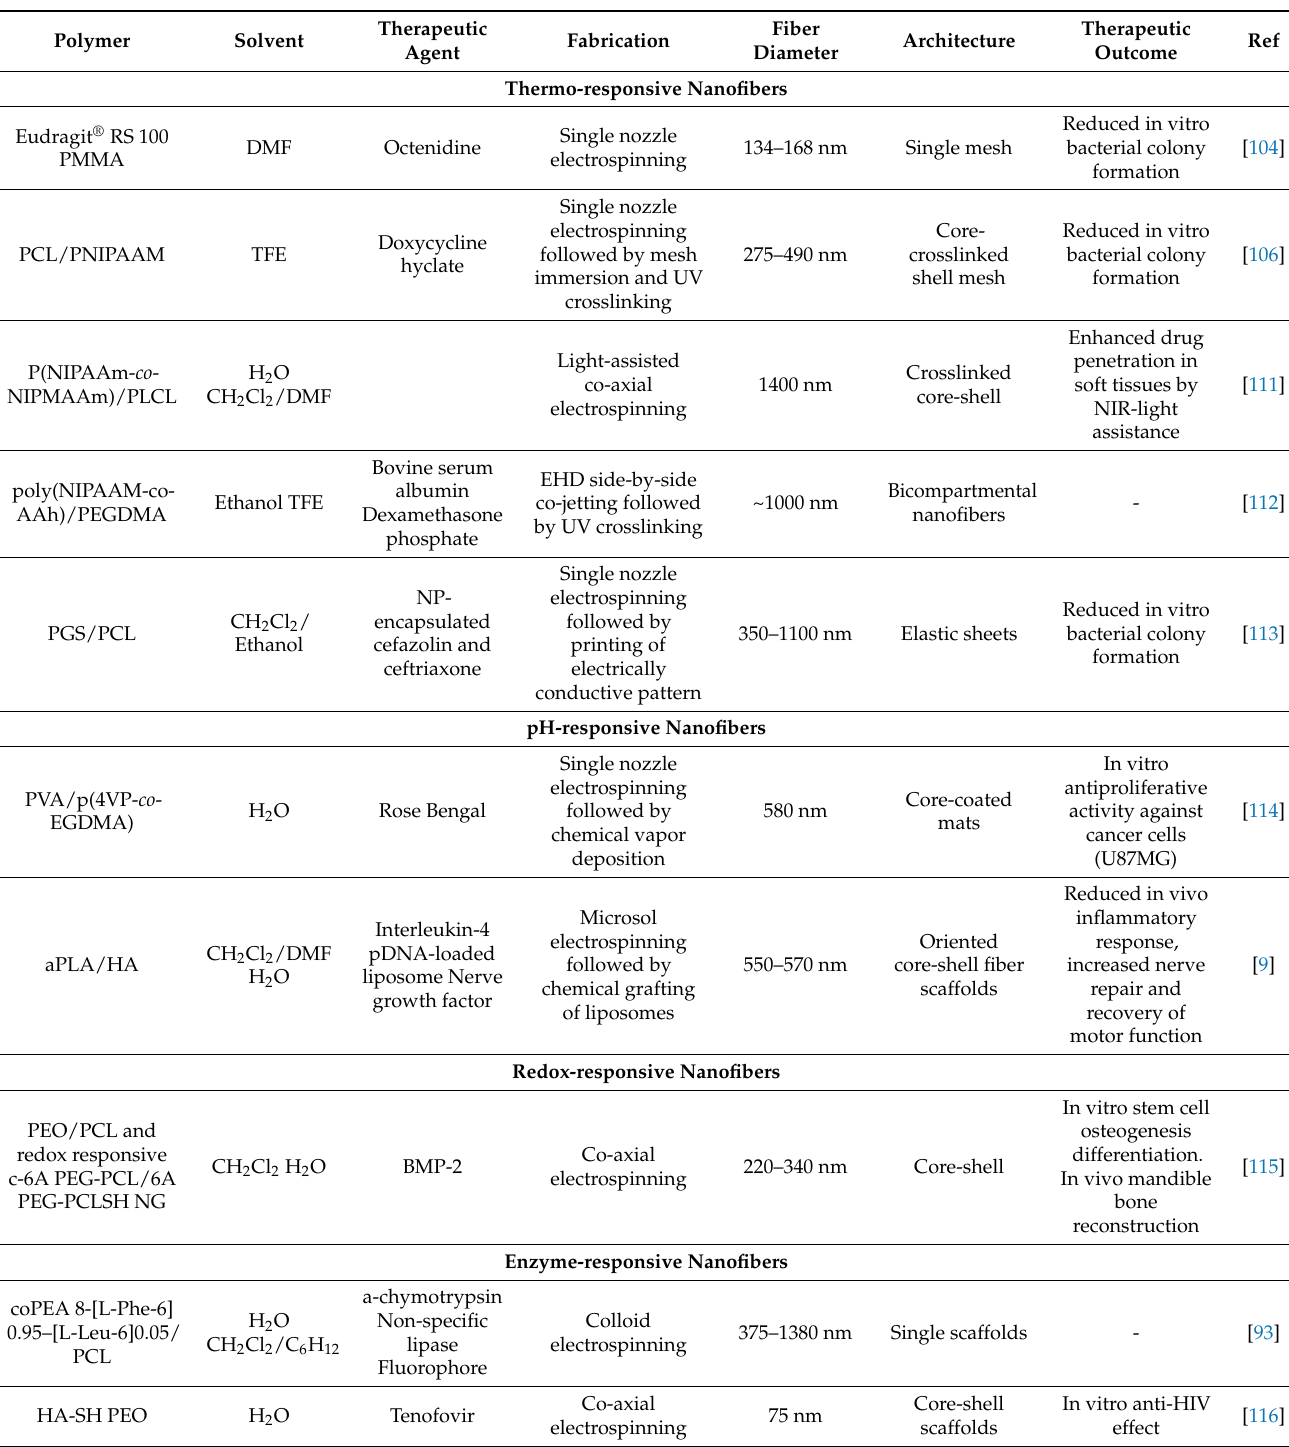
Table 1. Overview of the external stimuli used in design of smart